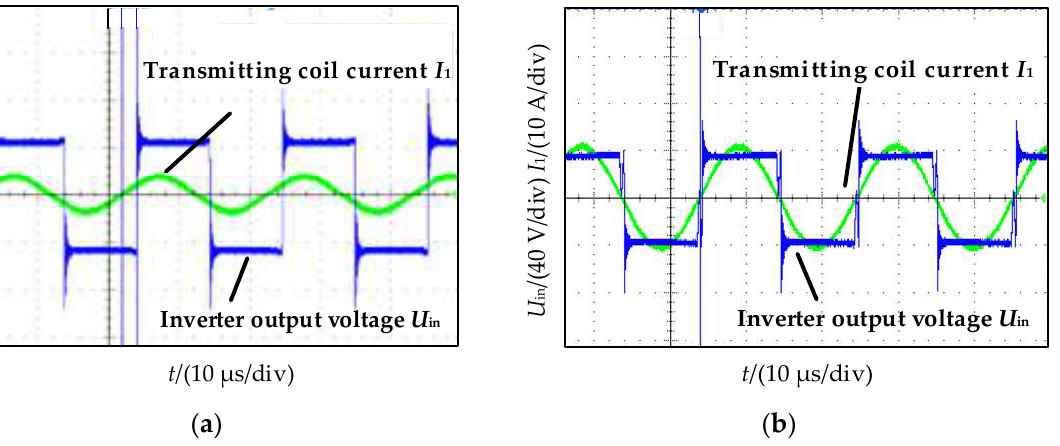
Figure 5. Voltage and current waveforms when the system is capacitive: ( a ) R L = 5 Ω, coil distance of 25 cm; ( b ) R L = 15 Ω, coil distance of 15